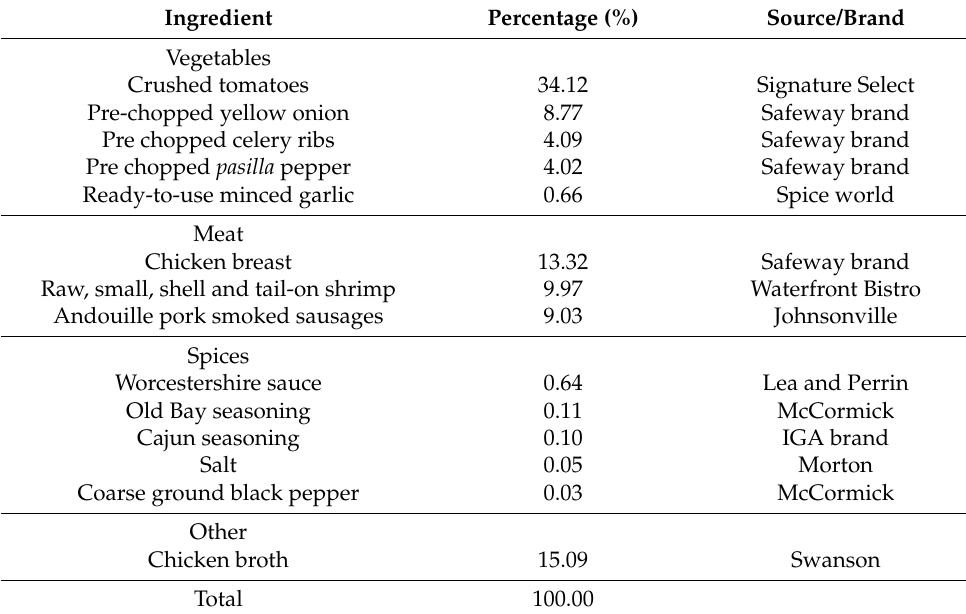
Table 1. Jambalaya formulation and ingredient specifications.